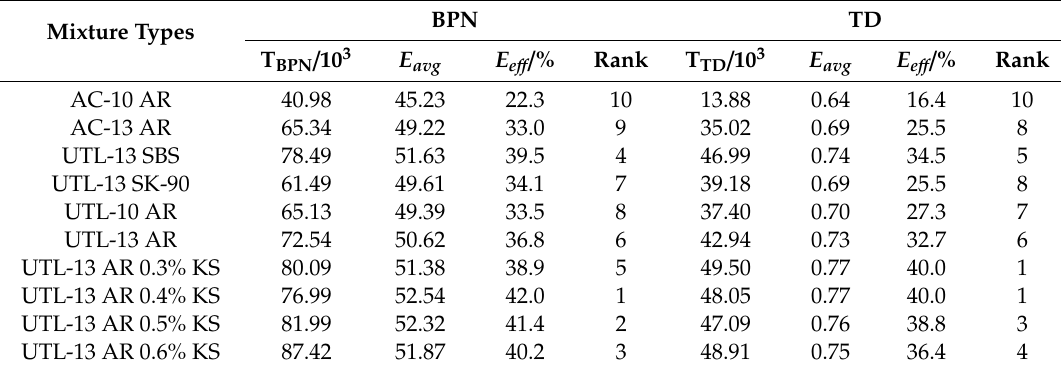
Table 10. Long term benefit analysis of skid resistance indexes of asphalt